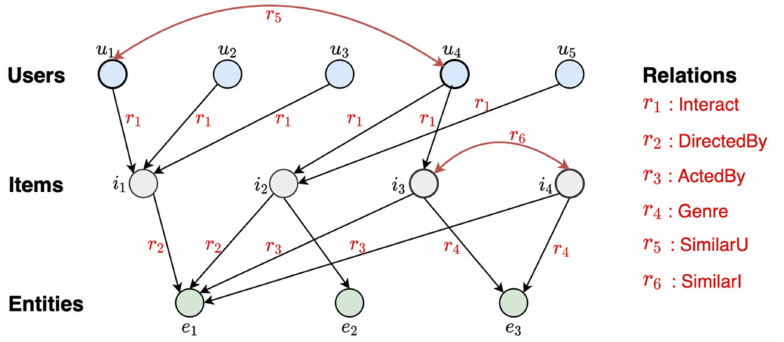
Figure 2. Improved collaborative knowledge graph (ICKG). The red arrow r 5 indicates the connected edges of similar users, and r 6 indicates the connected edges of similar